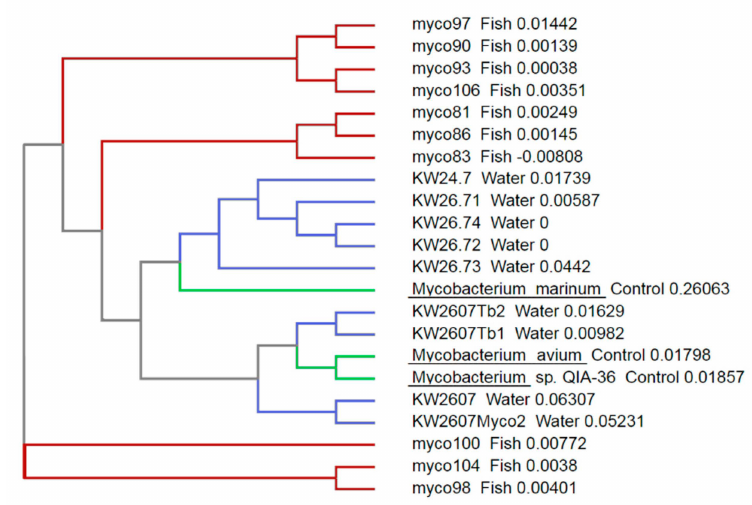
Figure 2. Phylogenetic tree constructed by ClustalW analysis of the 16S rRNA sequences from the amplicons from the present study. Sequences of these amplicons (water, indicated by blue branches) were compared to sequences from fish samples obtained during our previous samples of wild fish in the same rivers (fish, indicated by red branches, see Delghandi et al. [38]) and that of three control Mycobacterium sp. from the NCBI dataset (control, indicated by green